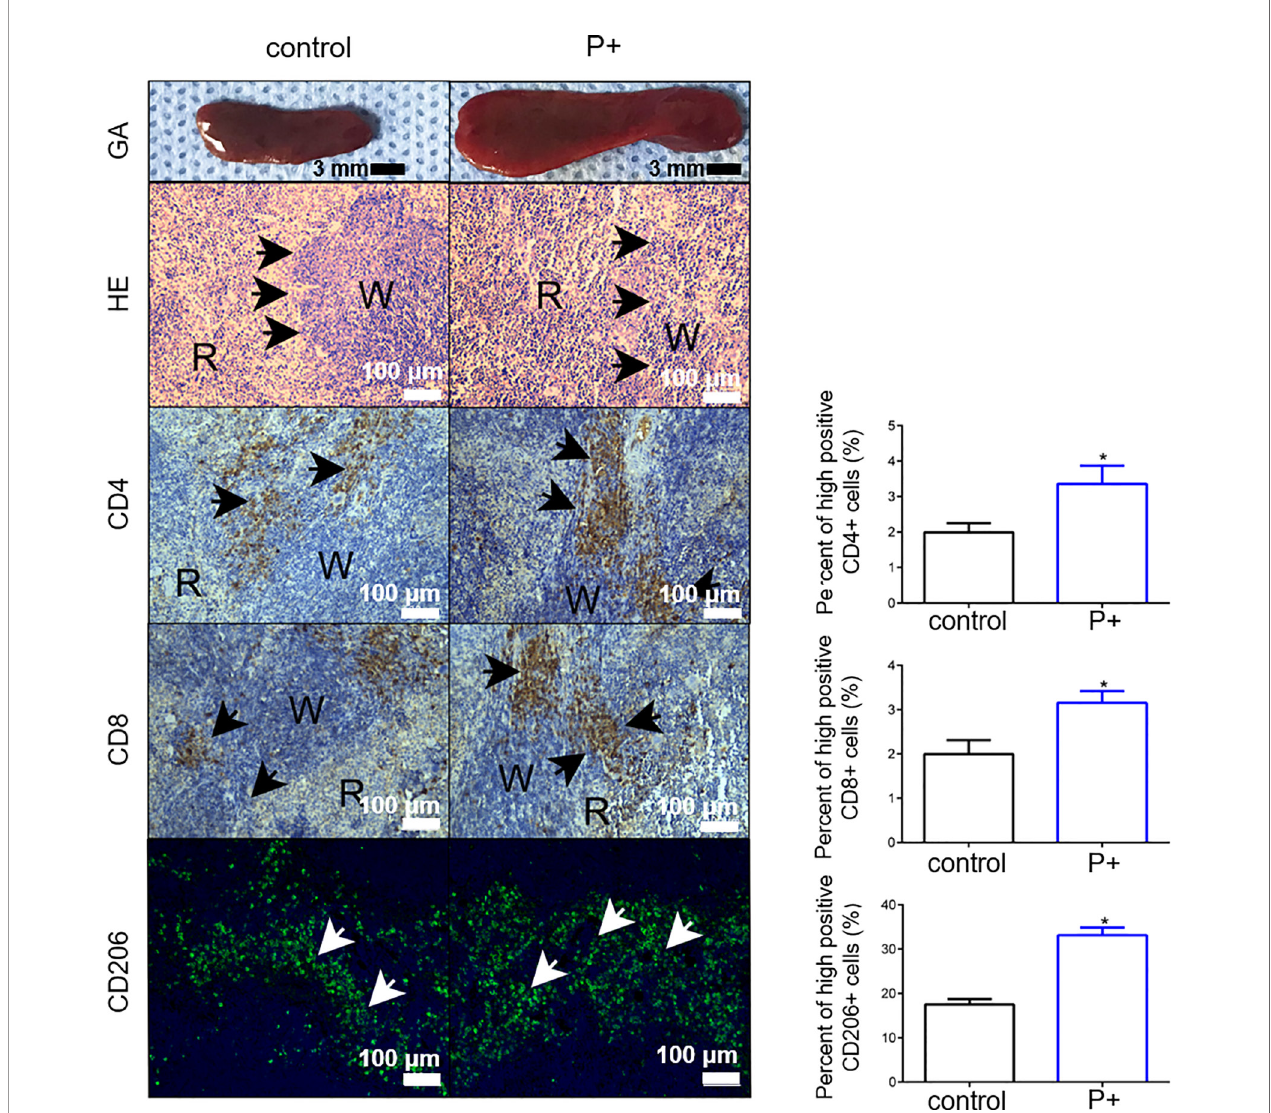
FIGURE 4 | The measurement of the volume of spleen tissue and H&E staining were performed to observe histological characteristics. The changes of CD4+ T cells, CD8+ T cells, and CD206+ T cells were detected for immune characteristics of the spleen. *p <